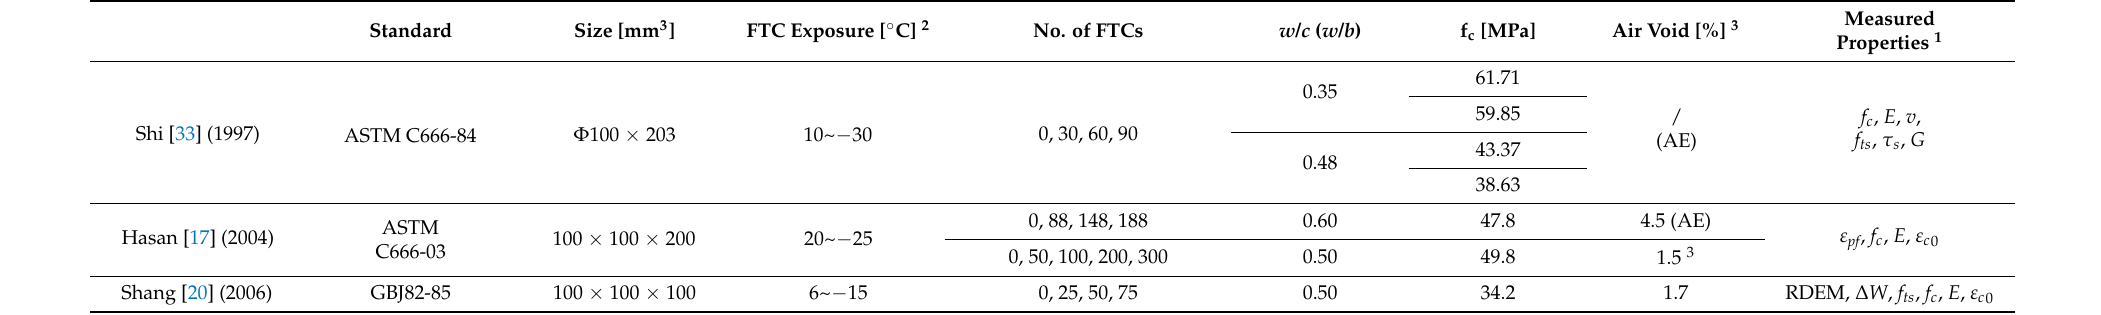
Table 2. Collected freezing-thawing data in laboratory